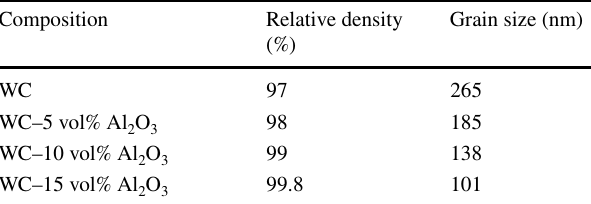
Table 3 Average grain size and relative density of pure WC and WC–Al 2 O 3 composite after the same HFIHS sintering conditions with same staring WC powders